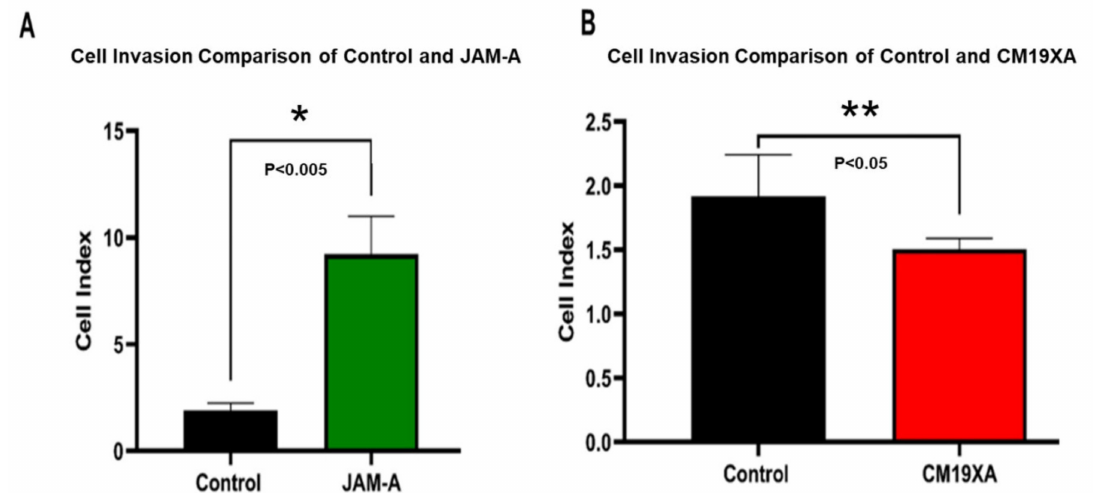
Figure 4. Cell invasion assay of CAL27 cells. ( A ) Comparison of Cell Index in the absence of exogenous proteins (control) or 1 µ M JAM-A. JAM-A triggers an increase of almost 8-fold invasion. ( B ) Comparison of Cell Index in the absence of exogenous proteins (control) or 1 µ M CM19XA. CM19XA decrease the rate of invasion by 25%. Statistical analysis was performed using Student’s t -test. Panel A, (*) p < 0.005; Panel B, (**) p < 0.05.